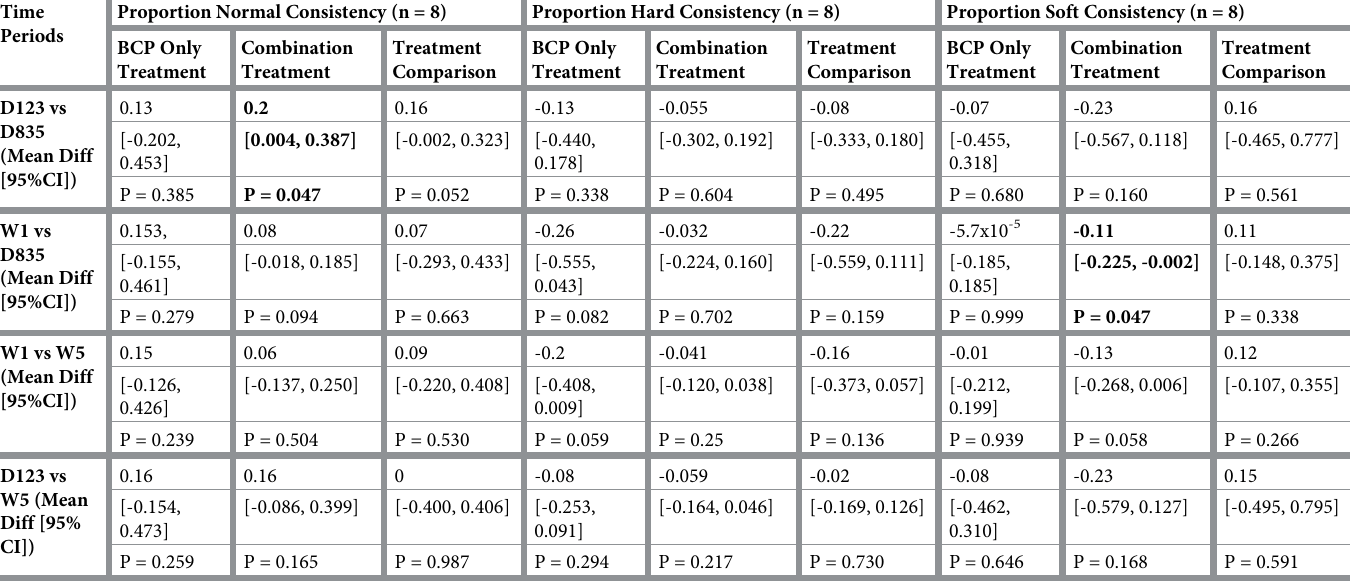
Table 4. Descriptive statistics for stool consistency from stool log